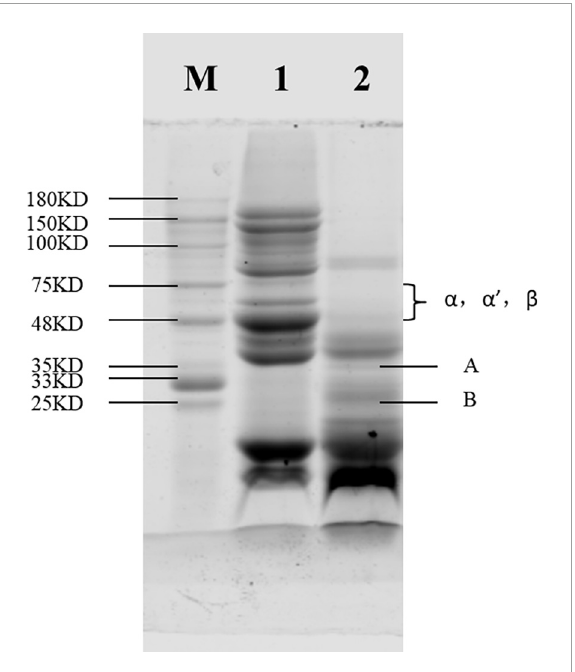
FIGURE1 Sodium dodecyl sulfate-polyacrylamide gel electrophoresis (SDS-PAGE) of soybean protein concentrate (SPC) after Alcalase protease hydrolysis. Note: In the figure, M is the standard protein, 1 express the unhydrolyzed SPC, and 2 express the hydrolyzed